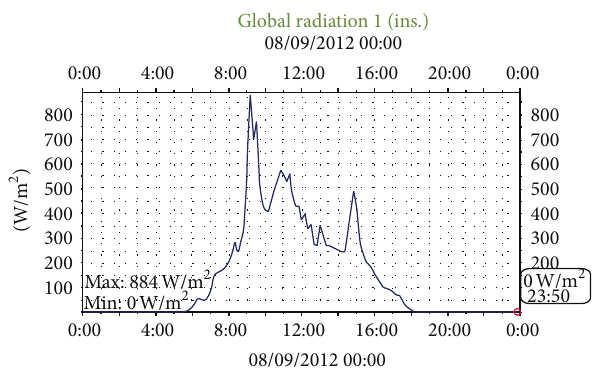
Figure 5: Variation of solar insolation photovoltaic on a typical sunny day at solar centre, KEC.